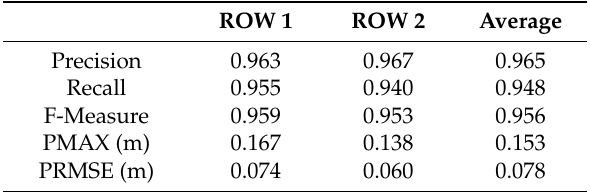
Table 4. Assessment of the power line point clouds extraction and fitting results.